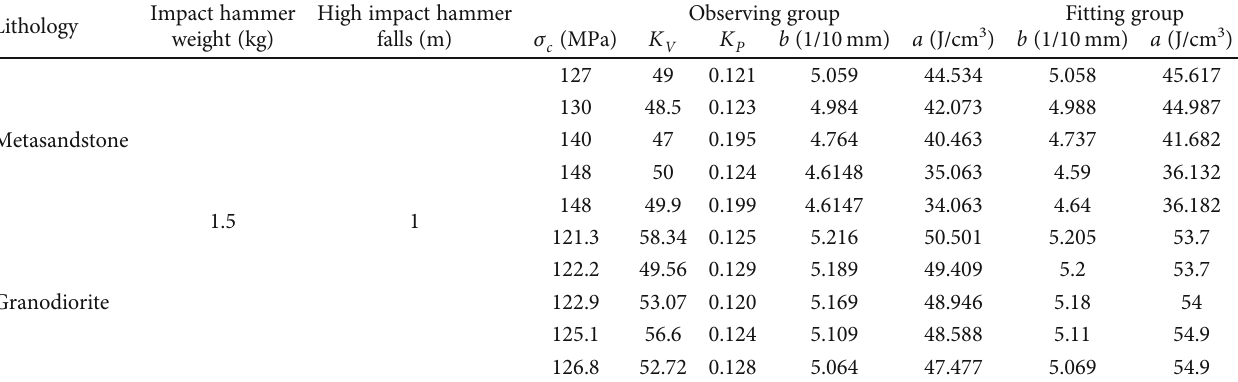
Table 7: Experimental veri fi cation table of chiseling speci fi c energy and abrasion performance.